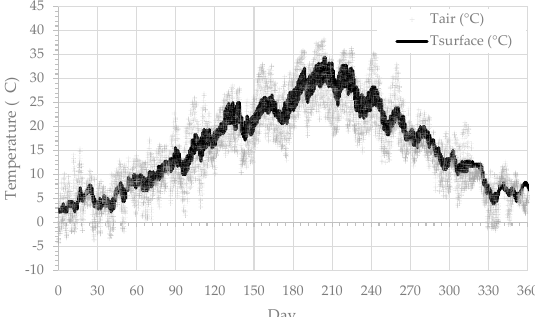
Figure 4. Time evolution of air and ground surface temperatures at TekneHub Laboratory (Ferrara, Italy, 2015).